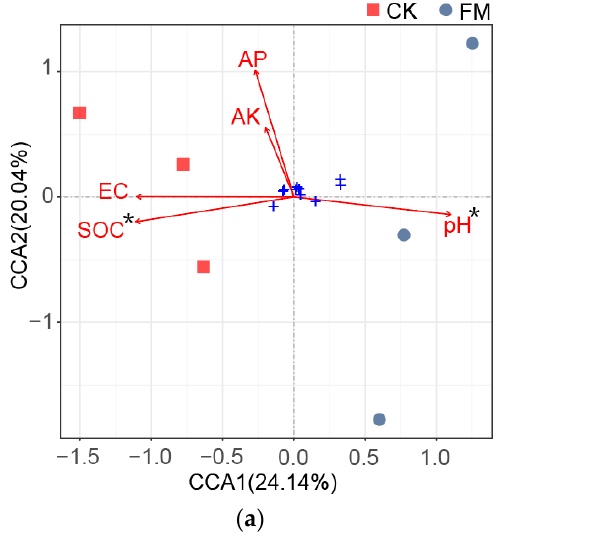
Figure 5. Correlation analysis of the soil physical and chemical properties and bacterial ( a ) and fungal ( b ) communities based on OTUs. The arrow length is directly proportional to the influence of soil physical and chemical properties on the microbial community structure. Three repetitions per group (n = 3). pH: acid-base; EC: electrical conductivity. SOC: soil organic carbon; AP: available phosphorus; AK: available potassium. “*” indicates that this factor has an important influence on the community. “ +” indicates the distribution of microbial communities in relation to envi- ronmental factors.